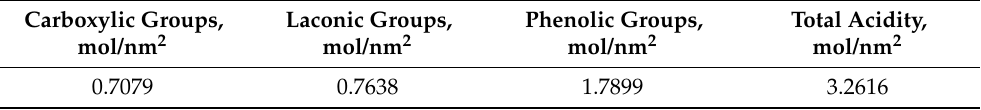
Table 8. Surface acid groups in